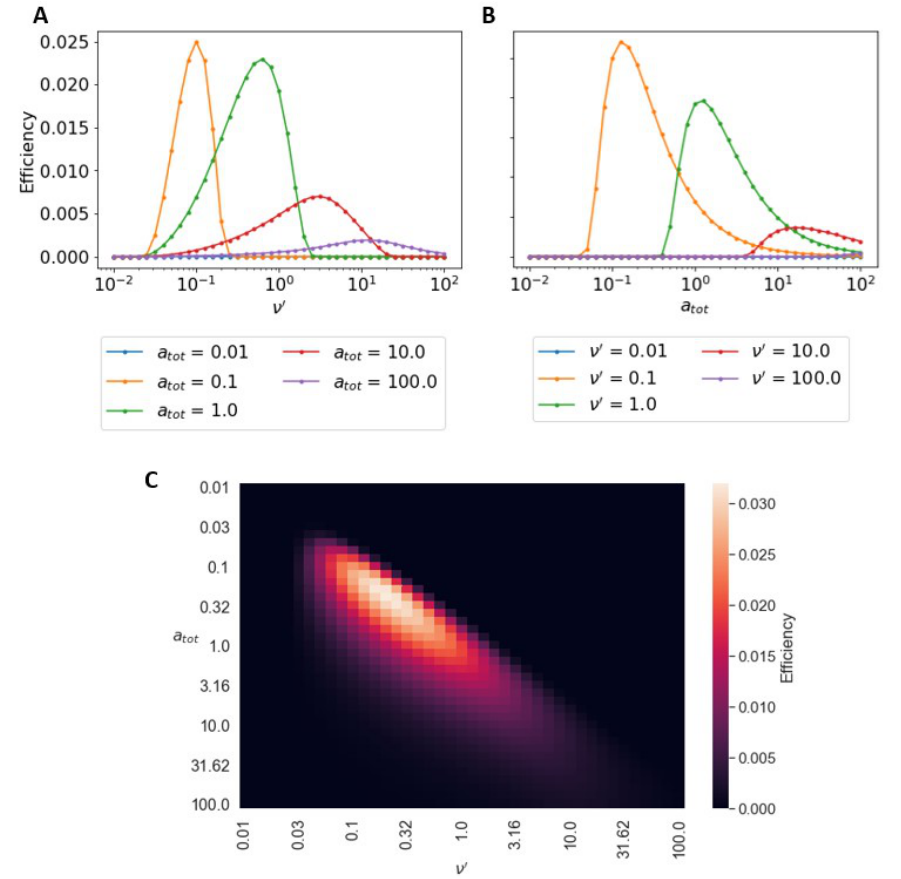
Figure 4. Dependence of efficiency on system parameters with no complex unbinding. ( A ) Stokes efficiency of system as a function of burn rate, ν (cid:48) at different substrate concentrations a tot . Given a tot , ν (cid:48) may be adjusted to provide maximum efficiency. Optimal efficiency coincides with ν (cid:48) that maximizes velocity. ( B ) Efficiency as a function of a tot at different burn rates, ν (cid:48) . ( C ) Heat map of the efficiency as a function of a tot and ν (cid:48) . There is an optimal a tot and ν (cid:48) that lead to the highest efficiency given a fixed amount of input chemical energy, ∆ g . In all of the above calculations, ω (cid:48) = 0, = K = 0.01, ∆ g = k (cid:48) of f